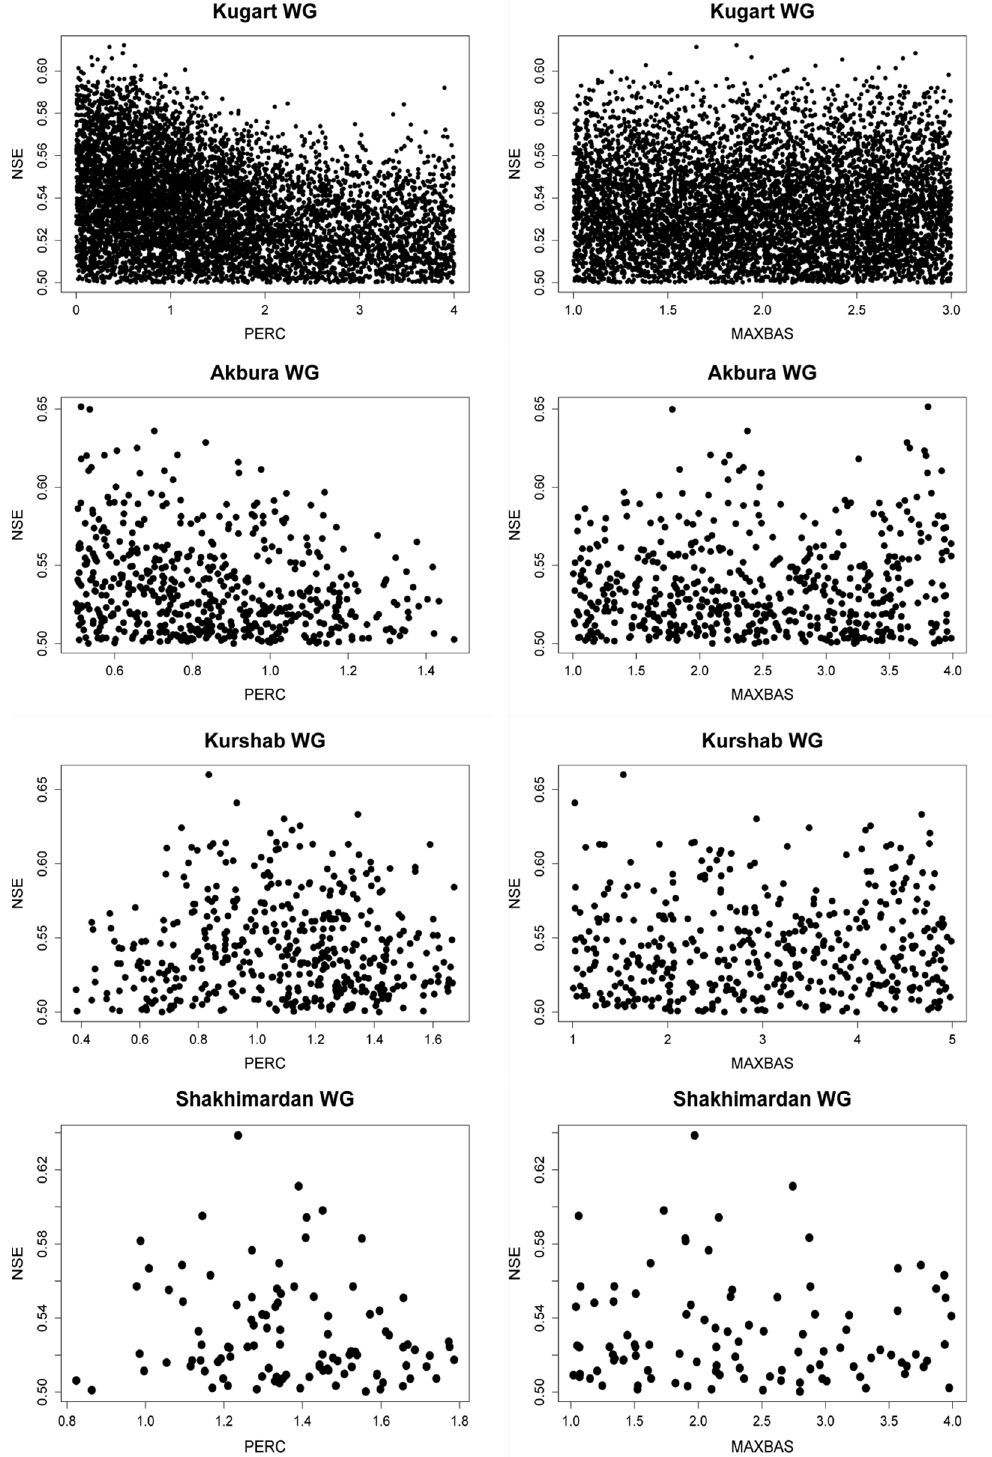
Figure 9. Examples of scatter plots with sensitive (PERC) and insensitive (MAXBAS) parameters for the four studied catchments with MODAWEC generated temperature